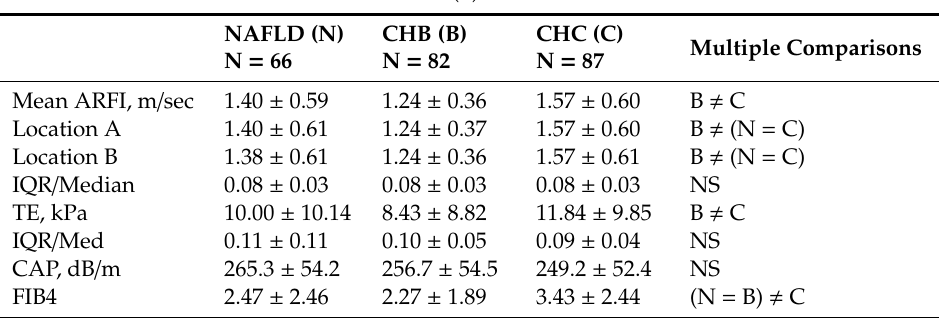
Table 2. ( a ) Liver fibrosis and steatosis parameters in patients who did not receive liver histology study; ( b ) Liver fibrosis and steatosis parameters in patients who received liver histology